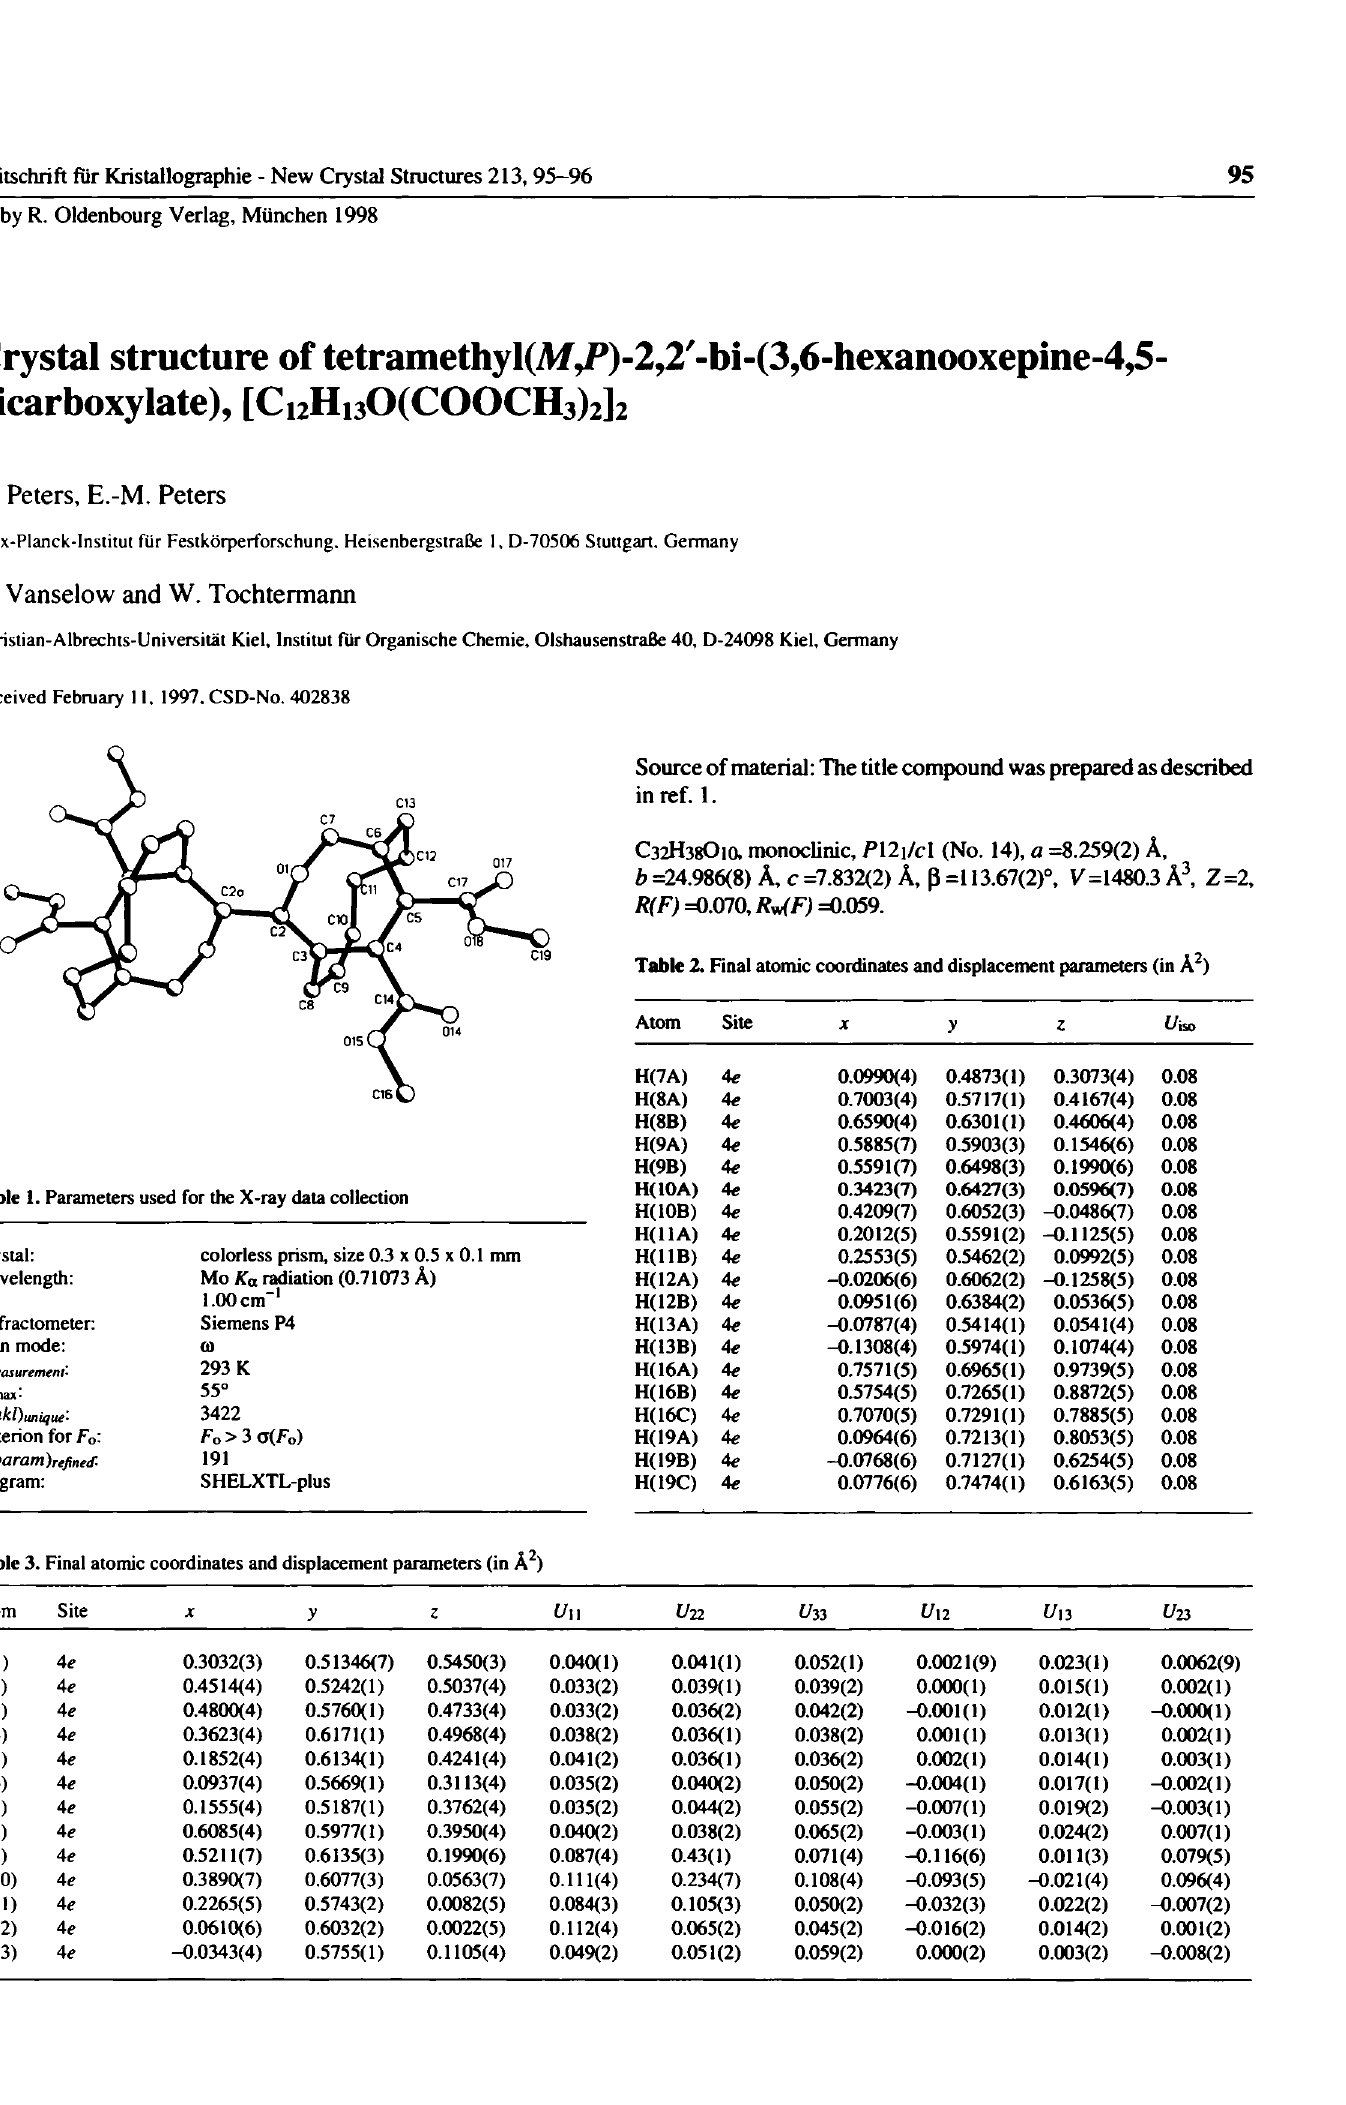
Table 1. Parameters used for the X-rav data collection